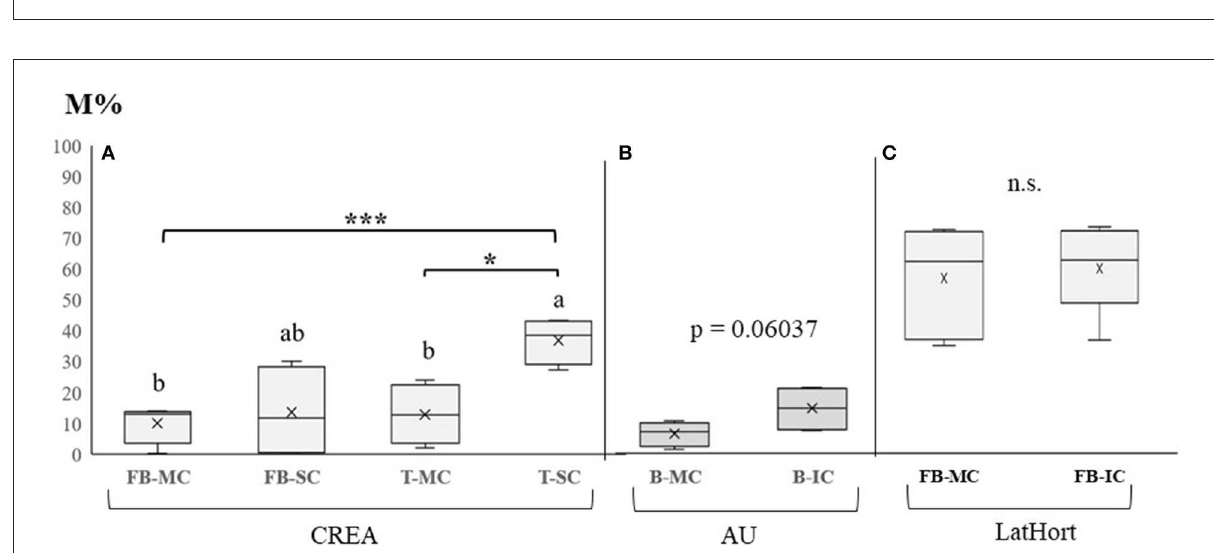
FIGURE4 Mycorrhizal colonization intensity (M%) recorded in (A) monocropped and strip cropped faba bean (FB-MC, FB-SC) and monocropped and strip cropped tomato (T-MC) and strip cropped, T-SC) (CREA, IT); (B) beetroot monocropping (B-MC) and intercropping (B-IC) systems (AU, DK); (C) faba bean in monocropping (FB-MC) and intercropping (FB-IC) systems (LatHort, LV). Levels of statistical significance are: * p < 0.05, ** p < 0.01, and *** p < 0.001, ns, not significant (ANOVA). Different letters represent significant differences (Tukey’s HSD test for means comparison).